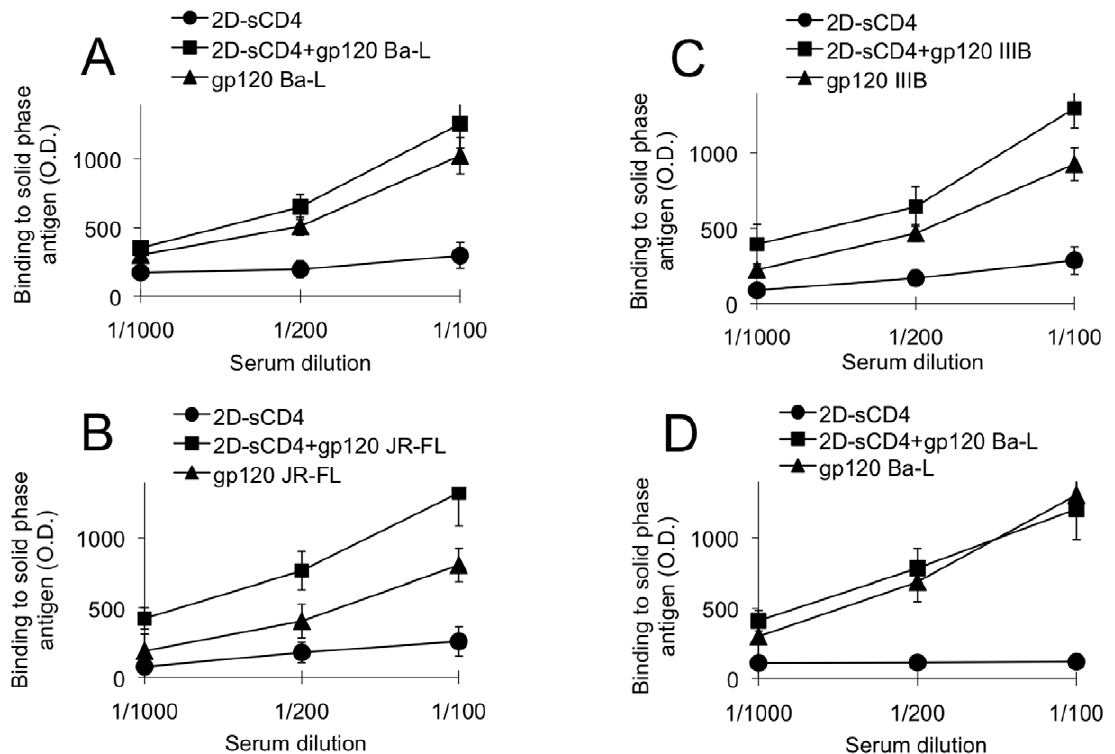
Figure 1. Detection of IgG anti-CD4 and anti-CD4-gp120 complexes in sera from mice immunized with CD4-complexed HIV-1 Env. he binding activity of IgG present in pooled sera obtained from mice immunized with NIH-3T3 cells expressing HIV-1 Env from various viral isolates bound to soluble CD4 ( A,B,C ) or from control mice immunized with cells expressing unbound HIV-1 Env ( D ) was tested by ELISA. The solid phase antigens used were recombinant HIV-1 gp120 complexed with equimolar concentrations of 2D-CD4, recombinant gp120 alone or 2D-CD4 alone. The binding activity was measured not only to Ba-L gp120 (1A and 1D), which is homologous to that used for immunization, but also to gp120 derived from heterologous viral isolates, JR-FL (Figure 1B) and IIIB